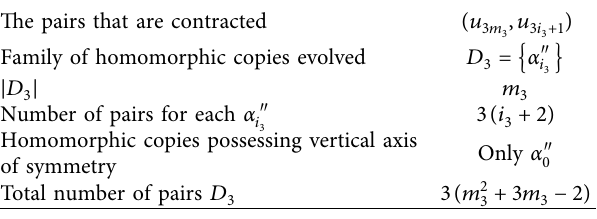
Table 4: Necessary information regarding homomorphic copies ′ 􏽮 􏽯 . β i 3